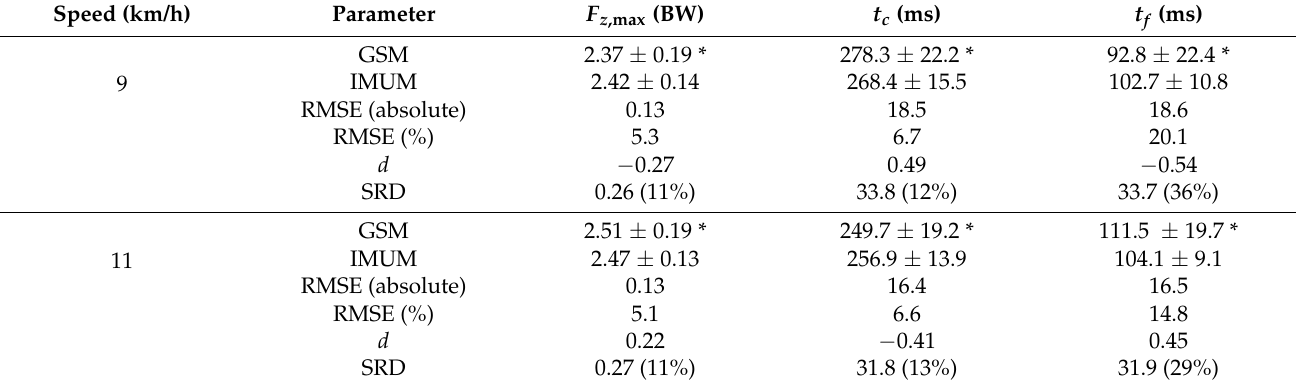
Table 2. Peak vertical ground reaction force ( F z ,max ), contact time ( t c ) , and flight time ( using the gold standard method (GSM) and inertial measurement unit method (IMUM) together with the root mean square error [RMSE; both in absolute (ms or BW) and relative (%) units], as well as Cohen’s d effect size and smallest real difference (SRD) for three running speeds. Significant ( p ≤ 0.05) method of calculation, running speed, and interaction effect, as determined by repeated measures ANOVA, are reported in bold font. * Significant difference between F z ,max , t c , and t f obtained using the GSM and IMUM at a given running speed, as determined by Holm post hoc